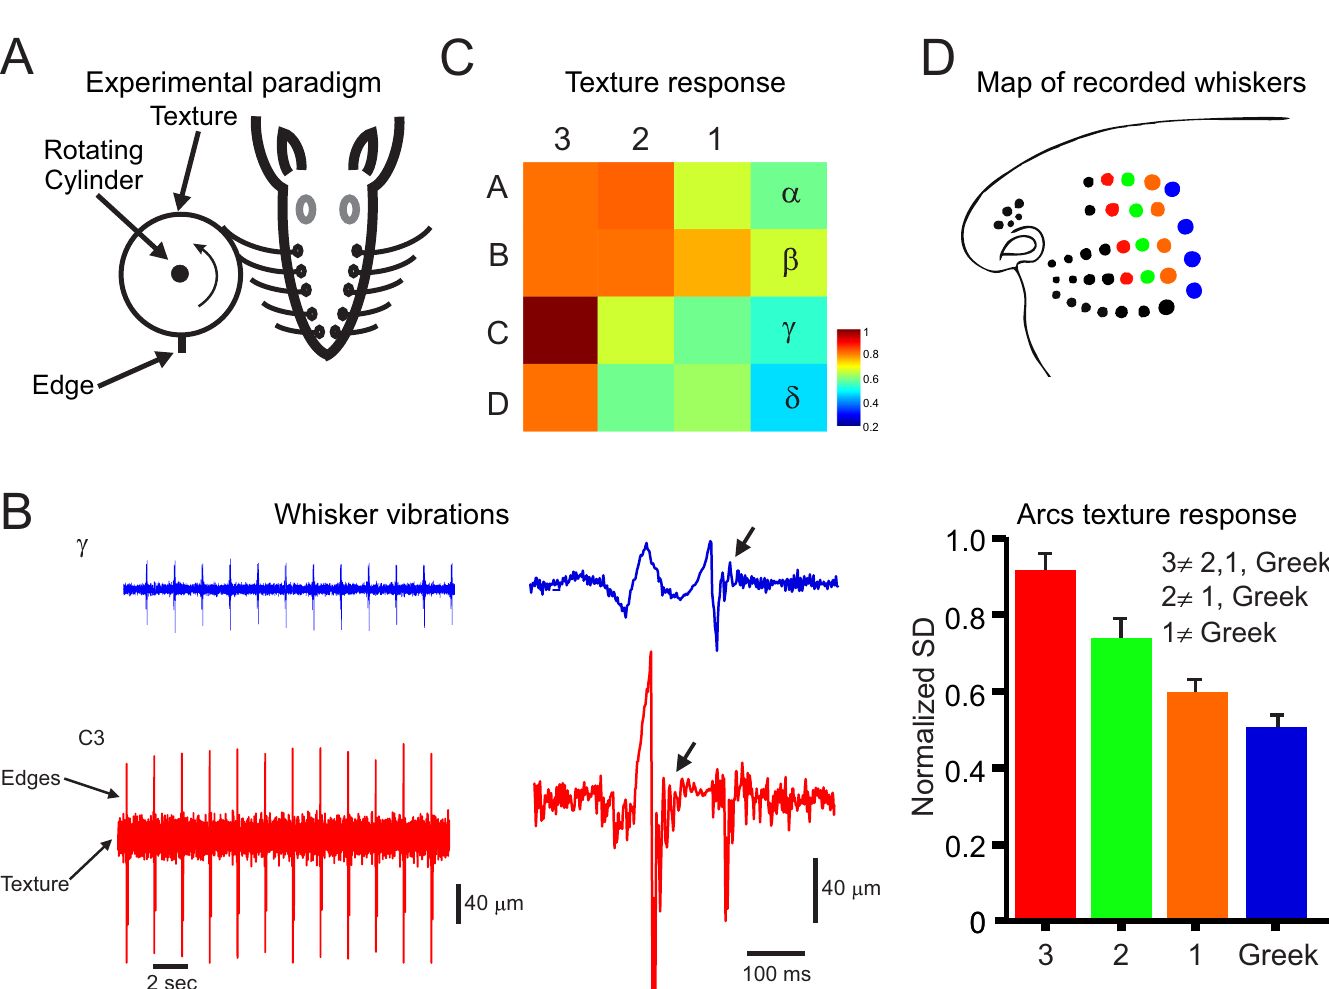
Fig 1. Differential biomechanical characteristics of different whiskers arcs. (A) Experimental design. The whiskers are contacting a rotating cylinder covered with textured sandpaper and an edge. (B) Example of 2 outermost whiskers’ vibrations in response to texture (P220) and edges. On the right, a magnified segment from the left panel showing whiskers’ motion while colliding with an edge and the resultant resonant movements (arrows). (C). Heat map of whiskers’ response movement SD to all textures across all whiskers. Each pixel denotes the normalized whisker vibrations’ SD to the highest value in the map. (D) The upper panel shows the recorded whiskers. The lower panel shows the mean and SD of each of the arcs in C. The inequality sign indicates a statistically significant difference between the various arcs. The underlying data for this Figure can be found in S1